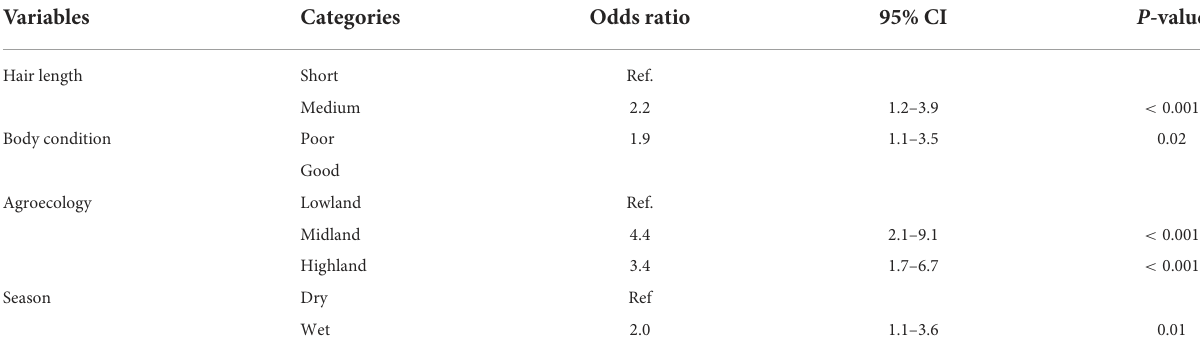
TABLE 4 Multivariable logistic regression analyses of risk factors associated with sheep lice infestation in Sayint district, South Wollo, Ethiopia.